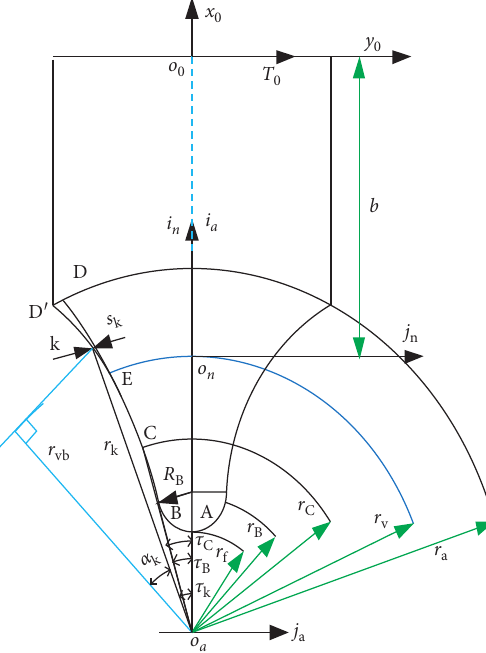
Figure 2: Design of the milling axis y in Figure 2 to form a disc milling cutter, and y 0